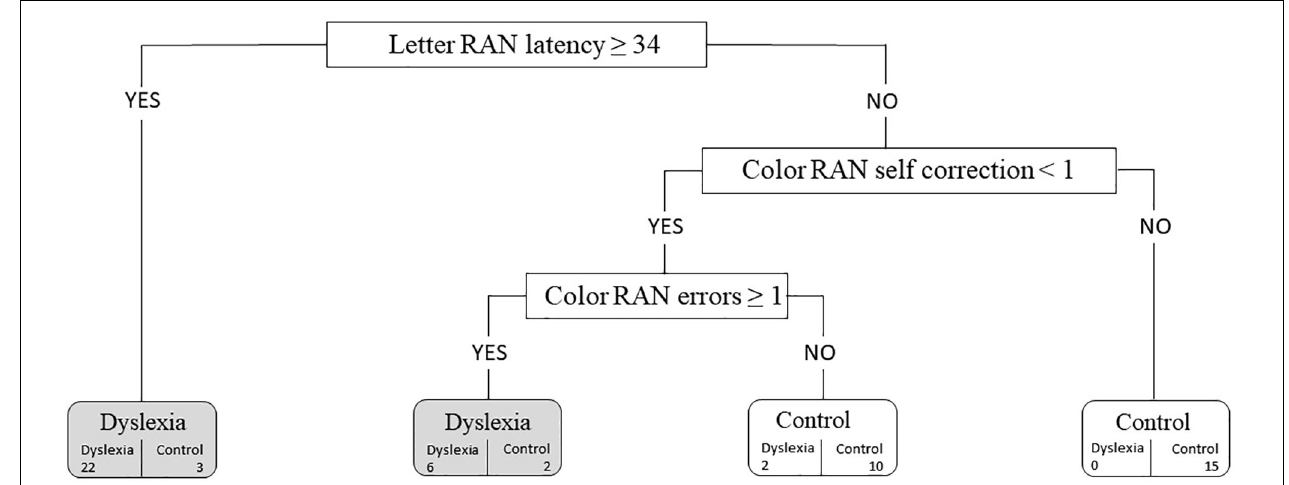
FIGURE 1 | The decision tree generated by the classification and regression tree (CART) analysis along with the dyslexia diagnosis data for each child node of the tree. Selected variables with cutoff values are represented in the boxes. Numbers at the bottom of the boxes with rounded corners represent the true number of individuals in each